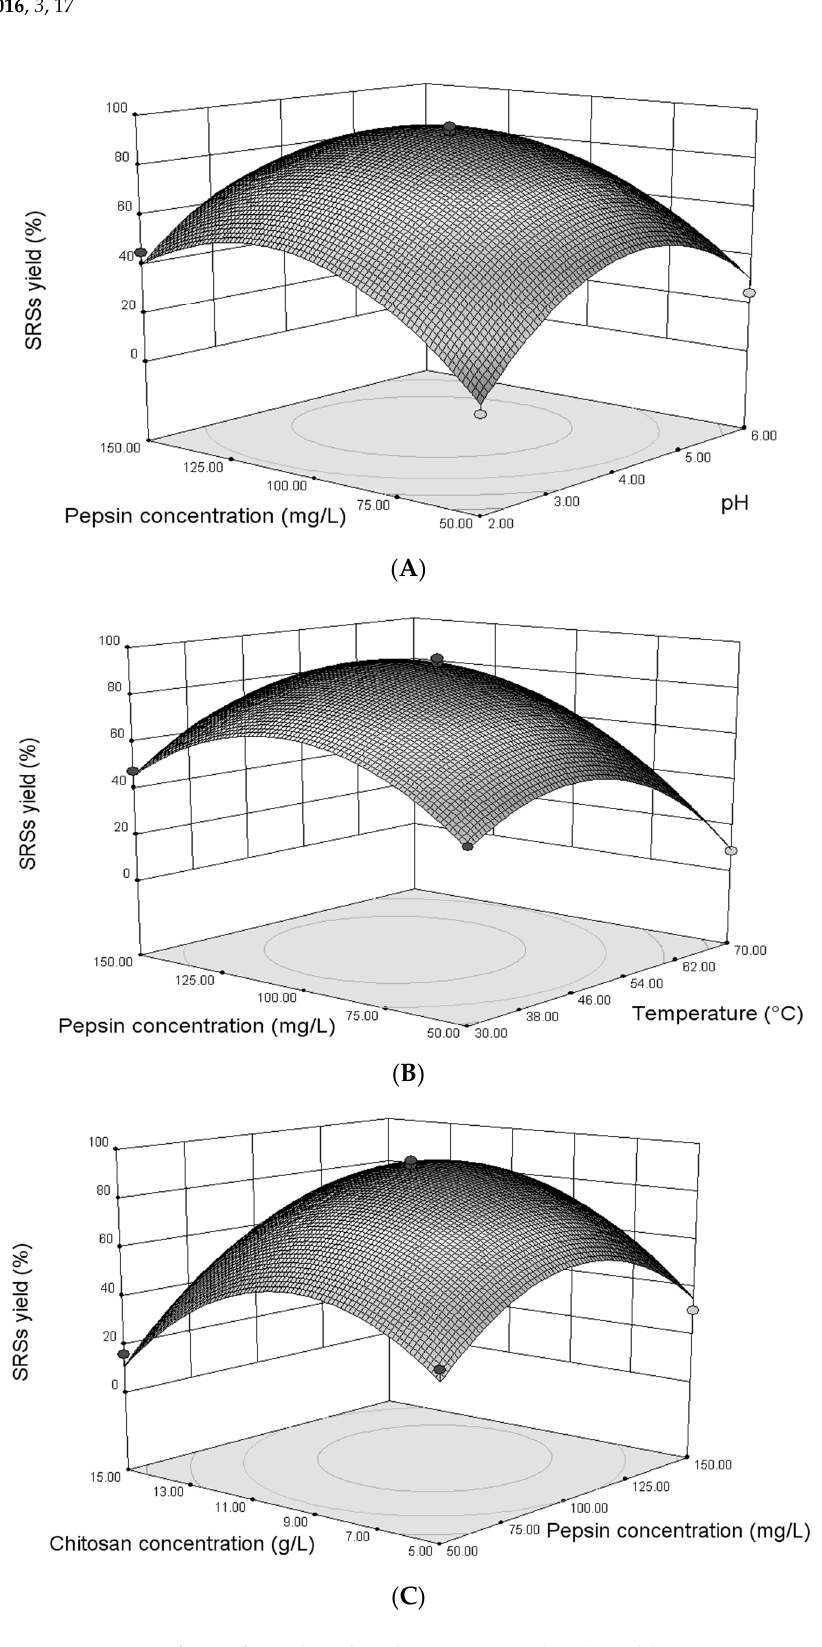
Figure 1. Response surface of predicted reducing sugar (SRS) yield versus pH and pepsin concentration ( A ); reaction temperature and pepsin concentration ( B ); chitosan concentration and pepsin concentration ( C ).